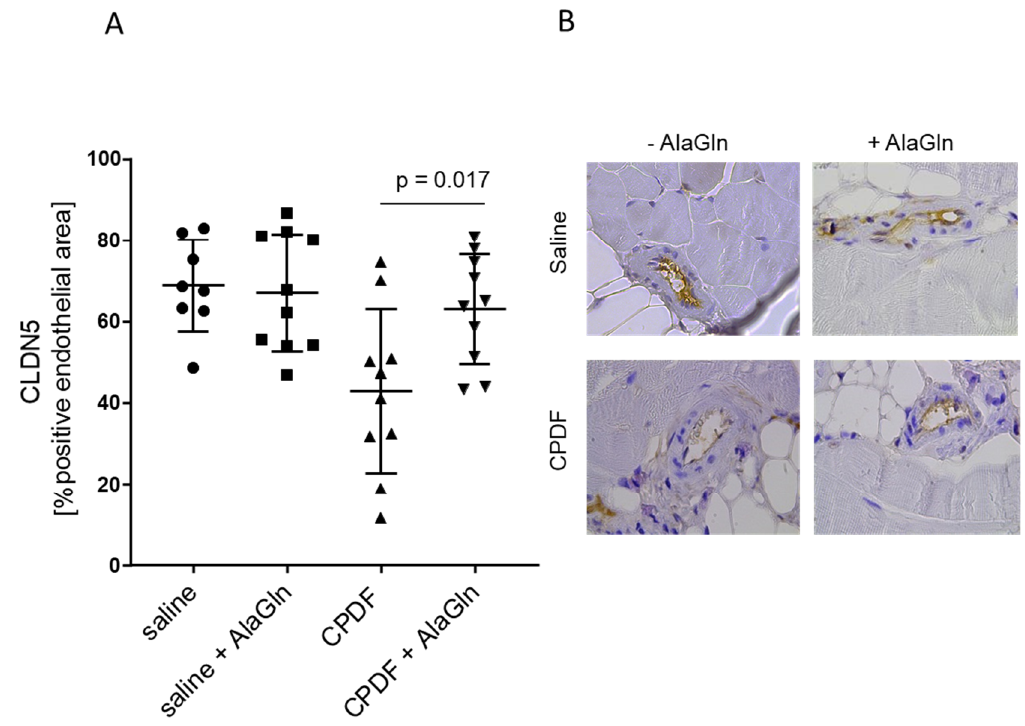
Figure 4. Supplementation of conventional PD fluid (CPDF) with 8 mM alanyl-glutamine (AlaGln) in mice treated for 7 weeks increased arteriolar endothelial CLDN5 abundance (left panel; means ± SD are given; p = 0.017 versus CPDF only) ( A ). Representative stainings of the mouse parietal peritoneum, illustrating upregulation of arteriolar endothelial CLDN5 with supplementation of AlaGln to CPDF ( B ). Scale bar = 50 µm.